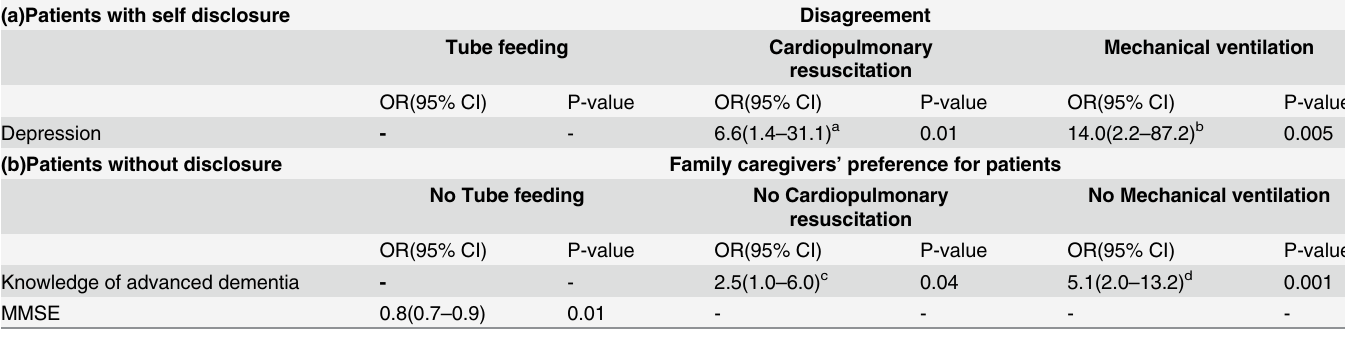
Table 3. Multiple logistic regression models of (a) disagreement of the life-sustaining treatment preference among patients with self disclosure and (b) family caregivers ’ preference for patient among patients without self disclosure. (a)Patients with self